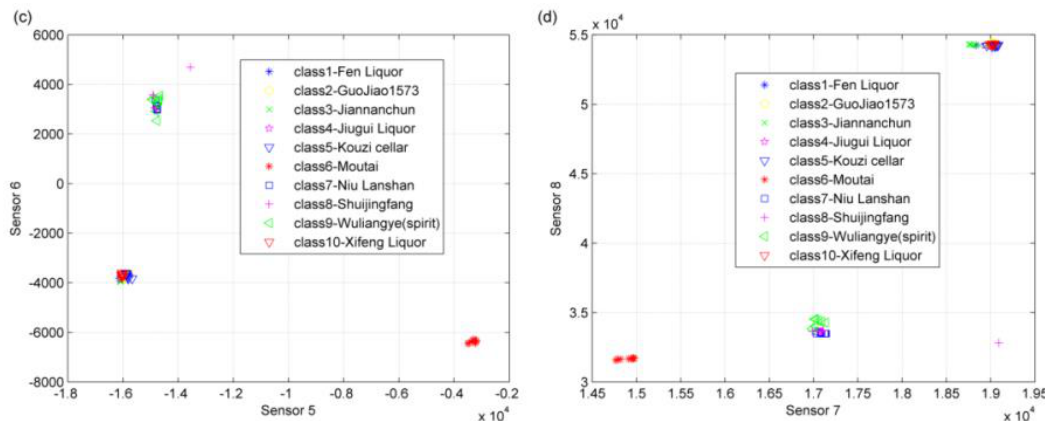
Figure 9. ( a ) Distribution of the 80 characteristic values for sensor 1 and sensor 2; ( b ) the distribution